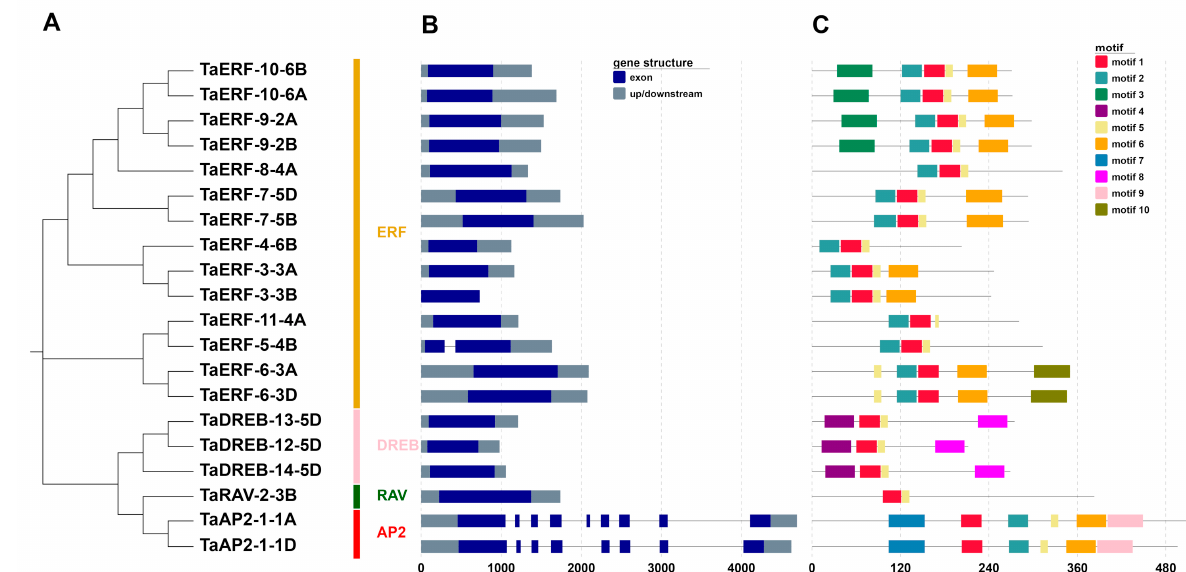
Figure 3. TaAP2/ERF family members analyzed according to ( A ) phylogenetic relationships, with division into four groups (AP2, RAV, DREB, and ERF); ( B ) gene structure, where exons and introns are indicated by dark blue boxes and dark gray lines, respectively; and ( C ) motif composition, with the 10 conserved motifs indicated with boxes of different colors.